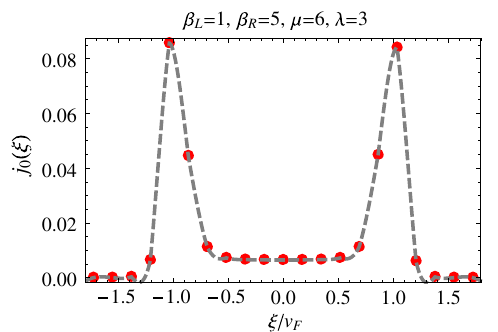
FIG. 9. A characteristic profile of the Lieb-Liniger particle ≪ μ , λ ¼ 3 , and μ ¼ 6 . The local maxima and current for T L;R minima are located around ξ ¼ (cid:4) v . The dashed curve is an F interpolation.